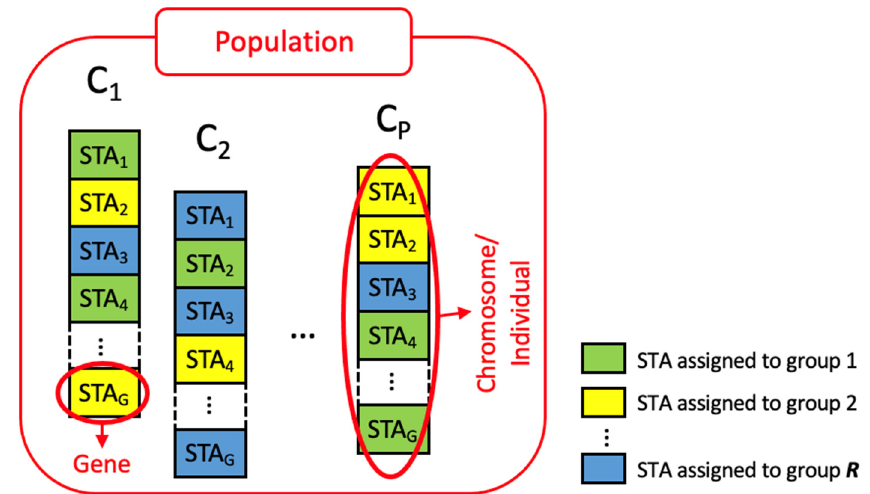
Figure 2. Modelling IEEE 802.11ah STAs grouping as a genetic optimization problem.